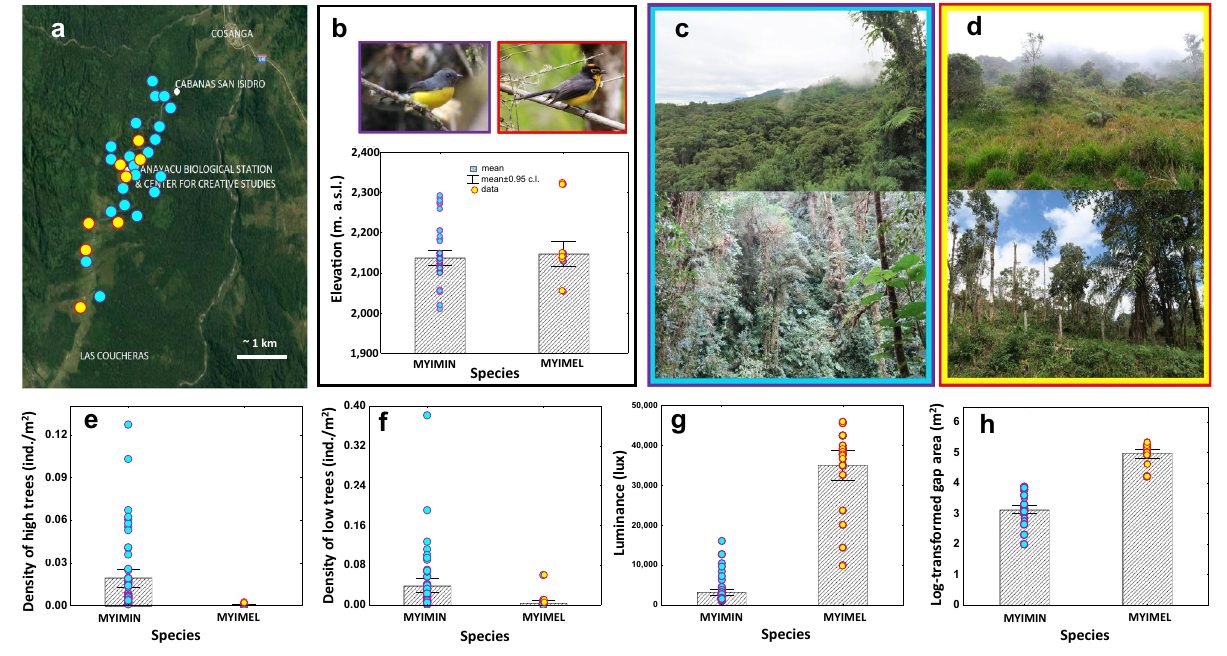
Figure 2. Characteristics of territories of Myioborus miniatus (MYIMIN; blue filled symbols with violet edges) and Myioborus melanocephalus (MYIMEL; yellow shading, red edges) at the study site. ( a ) spatial distribution of territories shown on the map of the study area; ( b ) distribution of the territories of M. miniatus and M. melanocephalus with respect to the elevation; ( c ) photos of typical habitats of M. miniatus at the study site; ( d ) photos of typical habitats of M. melanocephalus at the study site; ( e ) Comparison of density of trees higher than 15 m in territories of M. miniatus and M. melanocephalus ; ( f ) Comparison of density of trees lower than 15 m in territories of M. miniatus and M. melanocephalus ; ( g ) Comparison of luminance in territories of M. miniatus and M. melanocephalus ; ( h ) Comparison of forest gap surface area in territories of M. miniatus and M. melanocephalus . Based on n = 63 and n = 24 points measured in the territories of M. miniatus and M. melanocephalus , respectively. Photos by Jacek Nowakowski. Map Image in (A) retrieved from Google Maps on 16 October, 2019 (Imagery by TerraMetrics, Map data 2019). Summary statistics for variables presented in ( e – h ) are presented in the Supplementary Table